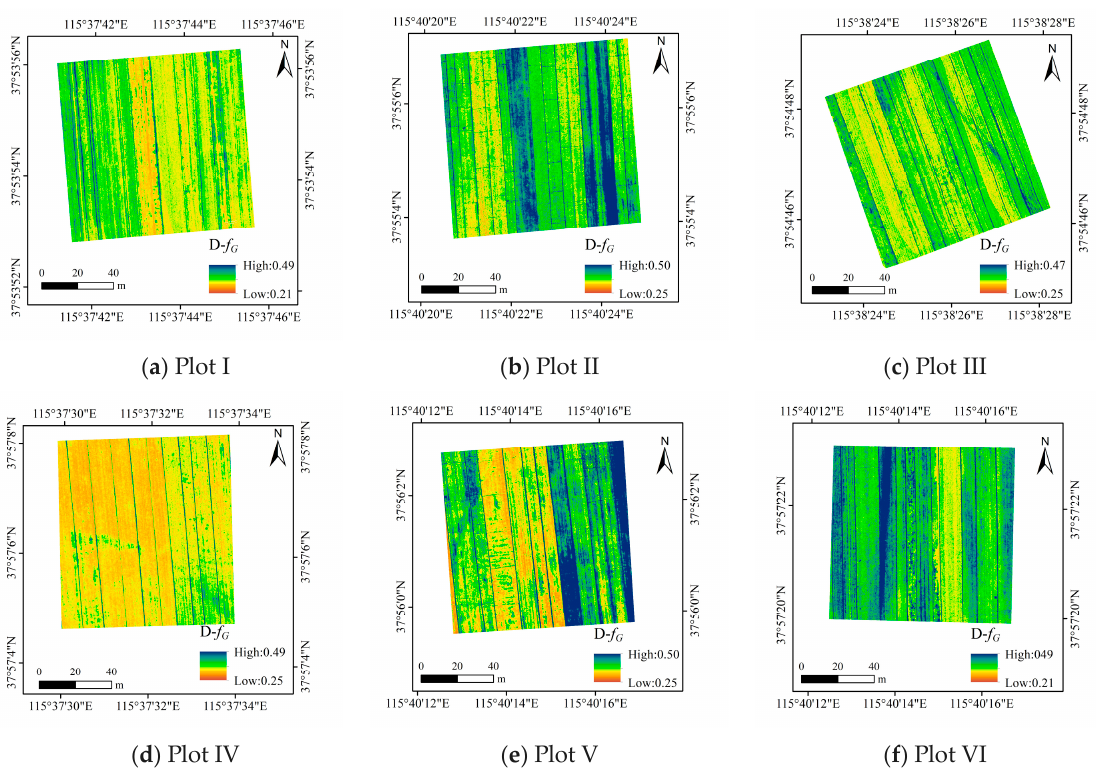
Figure 9. D- f G results of each flight plot based on the sensitive band centers λ (724 nm, 784 nm) (25 May 2021).